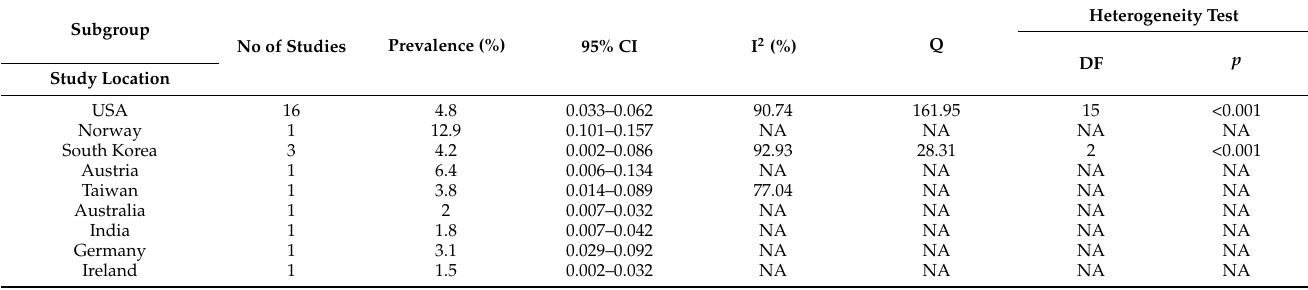
Table 2. Subgroup analysis. Prevalence of GNAS of patients with colorectal cancer stratified by study location of